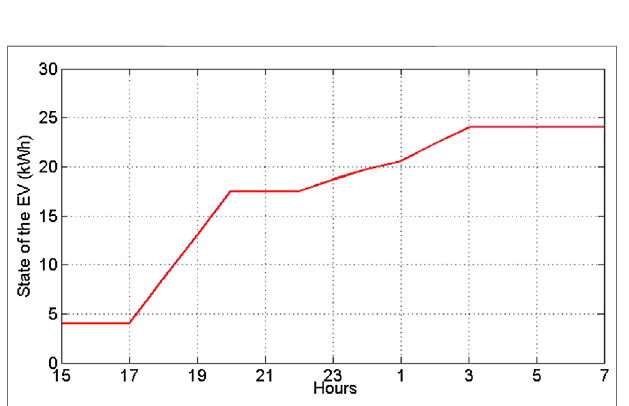
FIGURE 9 | Optimal PEV